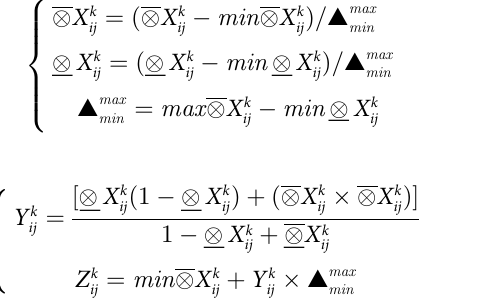
Table 5. Semantic variables of expert weights. Semantic variables Not important [0, 0.3] Less important [0.3, 0.5] important [0.4, 0.7] More important [0.5, 0.9] Very important [0.7, 1] Step 2 Develop specific grey matrices “B”.